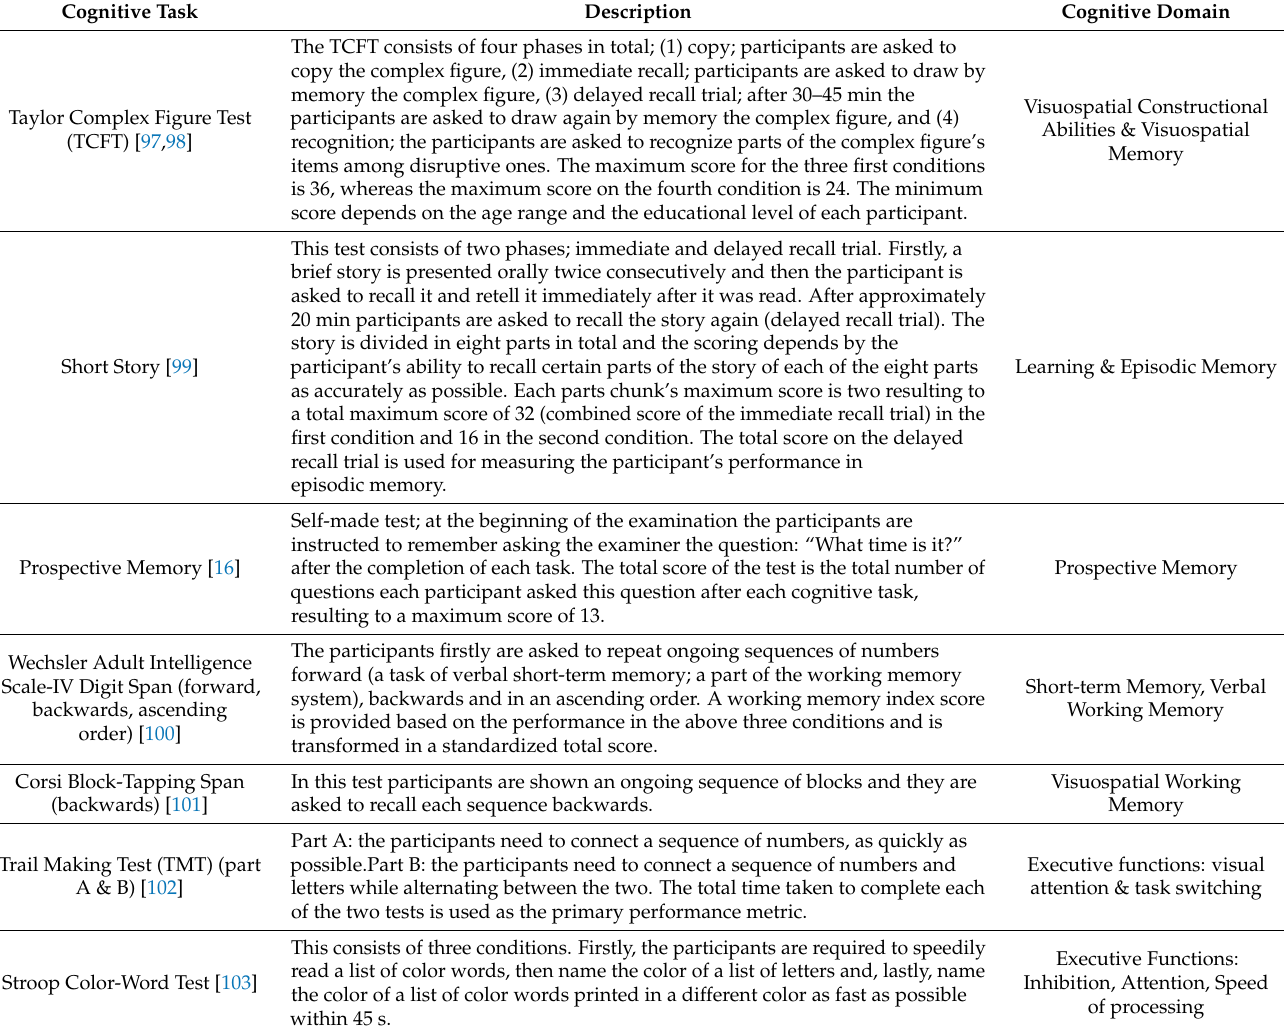
Table A1. Description of the tasks in the cognitive assessment battery.